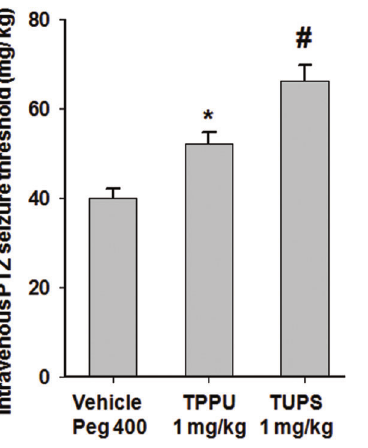
Figure 3. Potent inhibitors of sEH elevate threshold of tonic seizure in the timed i.v. infusion test. Consistent with the subcutaneous PTZ test both TUPS and TPPU, administered 1 h prior to PTZ displayed significant increases in the threshold of tonic seizure in response to i.v. infused PTZ (vehicle n=8, TPPU n=6, TUPS n=3, One Way ANOVA followed by Student Newman Keuls post hoc analysis